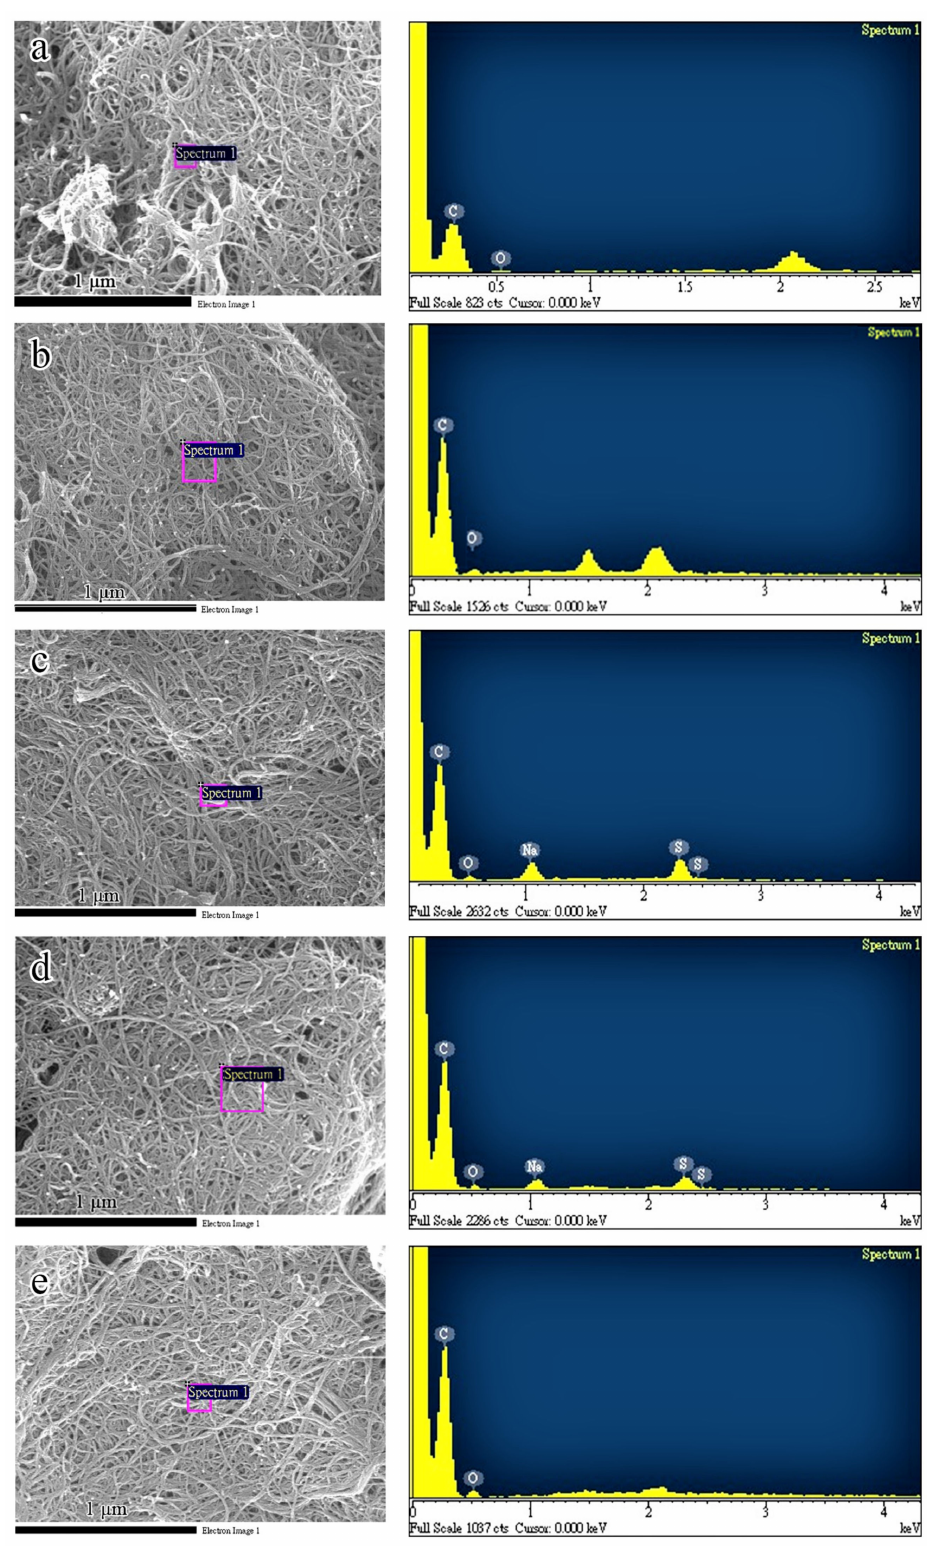
Figure 7. EDX analyses of various specimens. ( a ) S–BP; ( b ) S–BP–EDC/NHS; ( c ) S–BP–PSS; ( d ) S–BP–SDS; ( e )